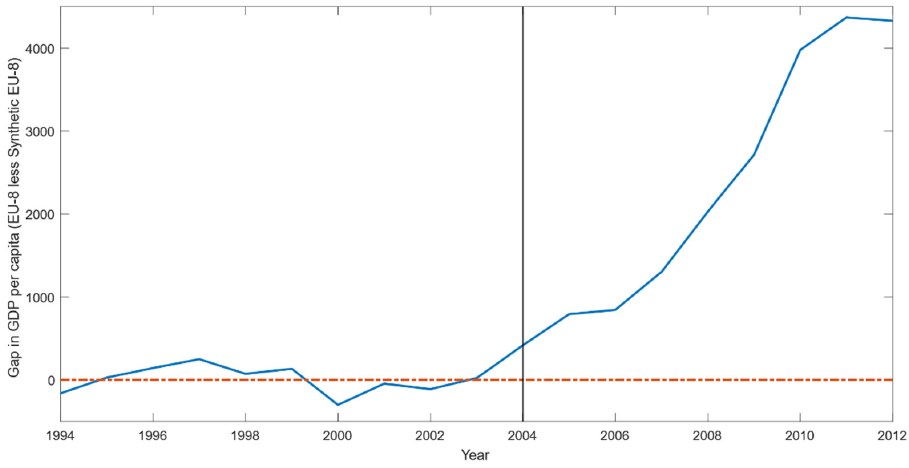
Figure 2. GDP per capita difference between EU-8 and synthetic EU-8.